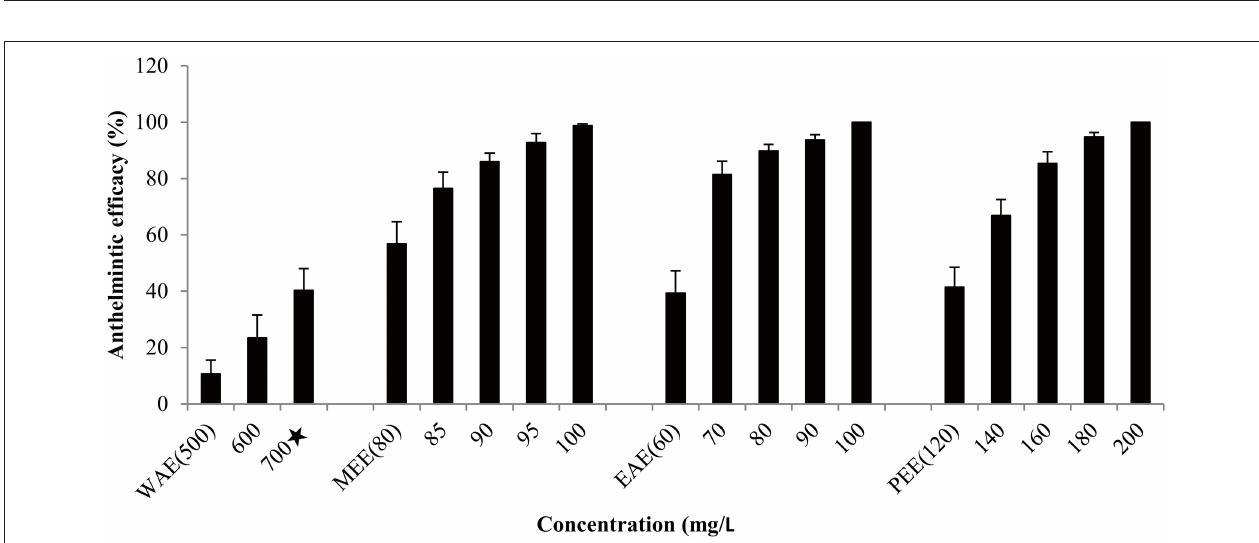
FIGURE 2 | Antiparasitic efficacy of different extracts of Solanum nigrum against Gyrodactylus kobayashii after a 48-h treatment. WAE, water extract; MEE, methanol extract; EAE, ethyl acetate extract; PEE, petroleum ether extract. A star indicates that fish death occurred.